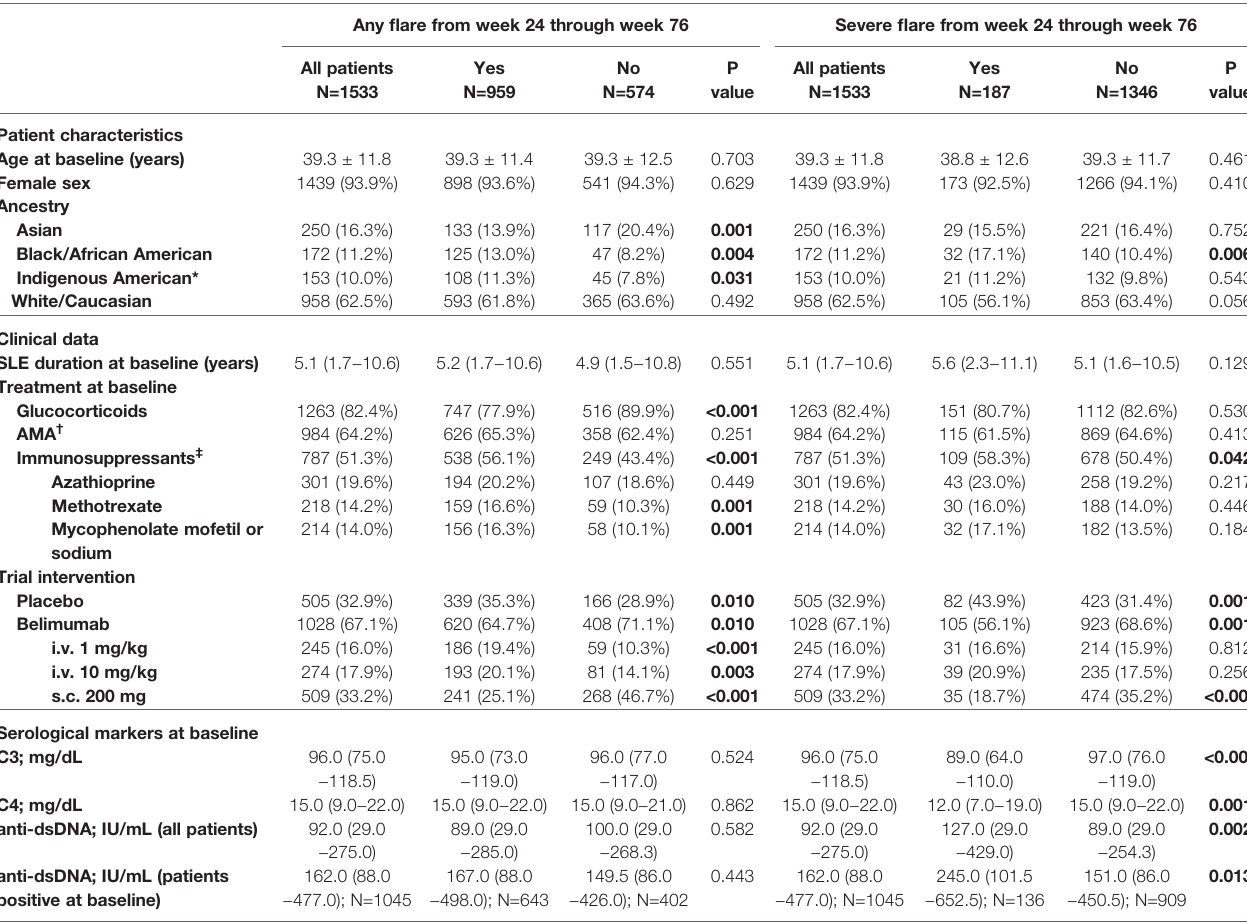
TABLE 1 | Characteristics of patients who developed versus patients who did not develop fl ares from week 24 through week 76 in the pooled BLISS study